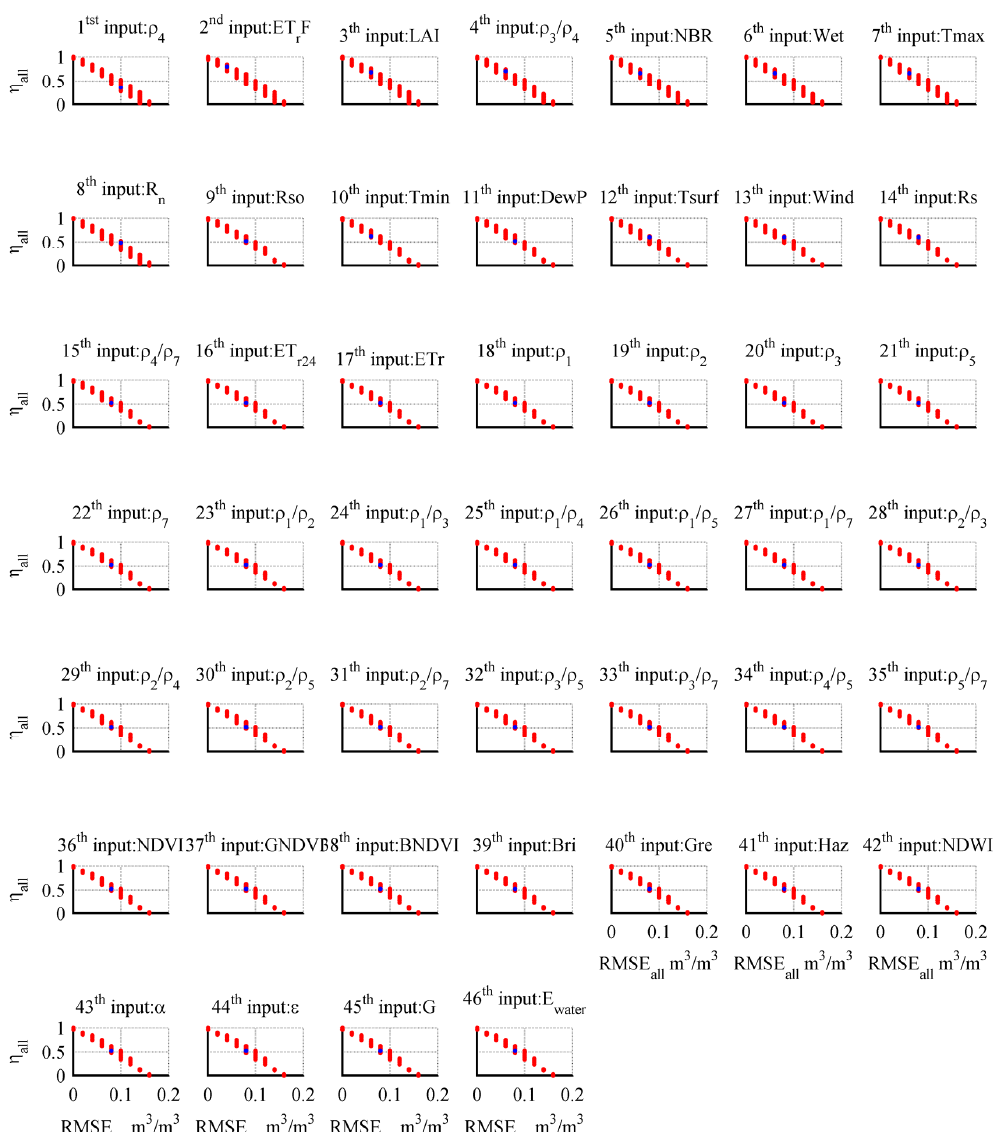
Figure 5. Example of RMSE and η values for fourty-six FPS iterations using RVM with a bubble kernel function. Subplot title indicated variable selected for the i-th FPS iteration. Red dots are statistical result values for considered kernel width values using all (Data). Blue dots are all (Data) statistical results of selected stratified CV inputs for each iteration.